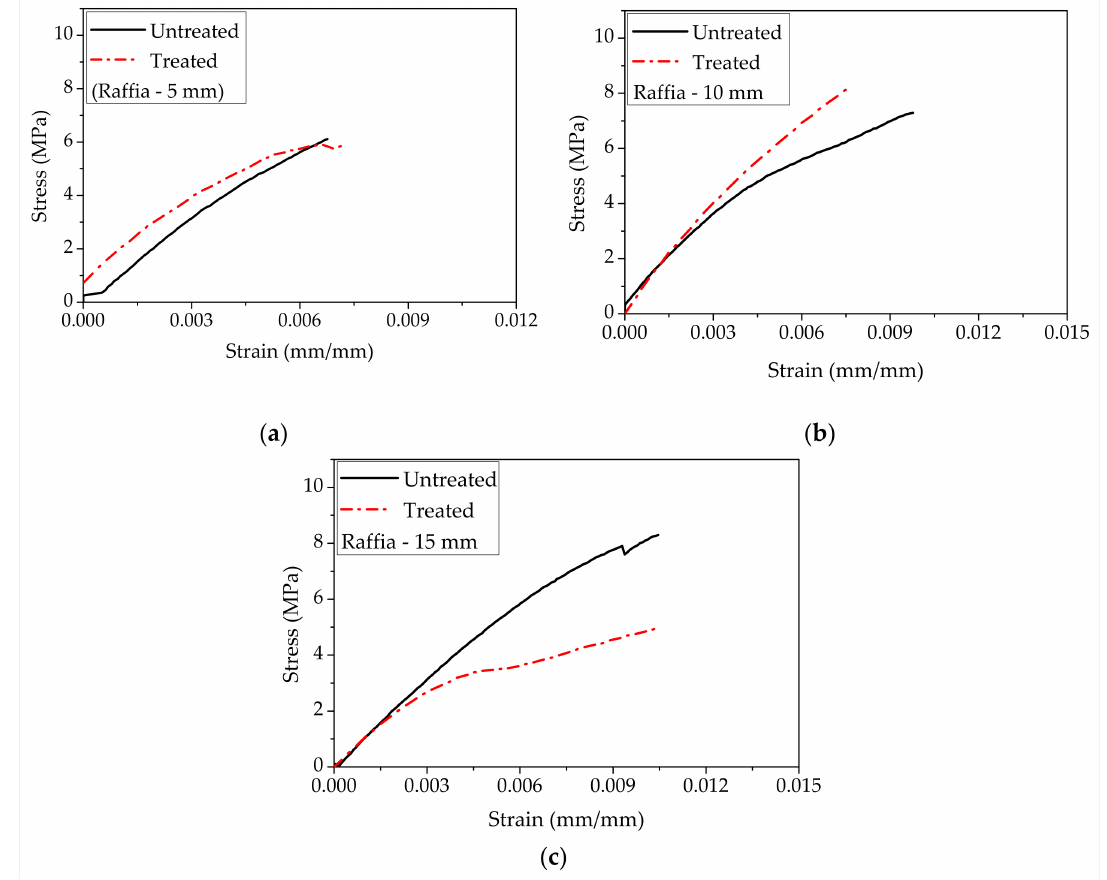
Figure 7. Stress-strain curves of ra ffi a fiber composites under alkali treated and untreated conditions with di ff erent fiber lengths: ( a ) 5 mm; ( b ) 10 mm; and ( c ) 15